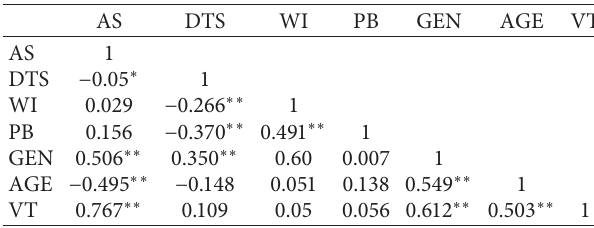
Table 5: Correlation coefficient matrix.